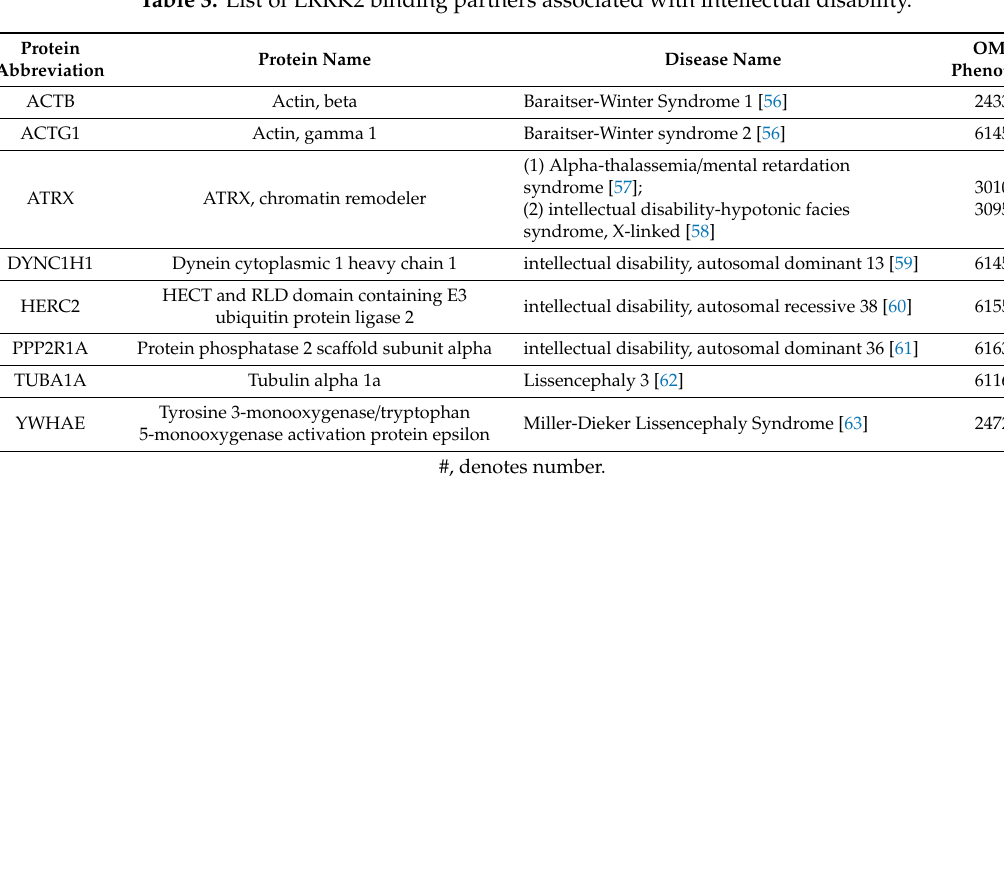
Table 3. List of LRRK2 binding partners associated with intellectual